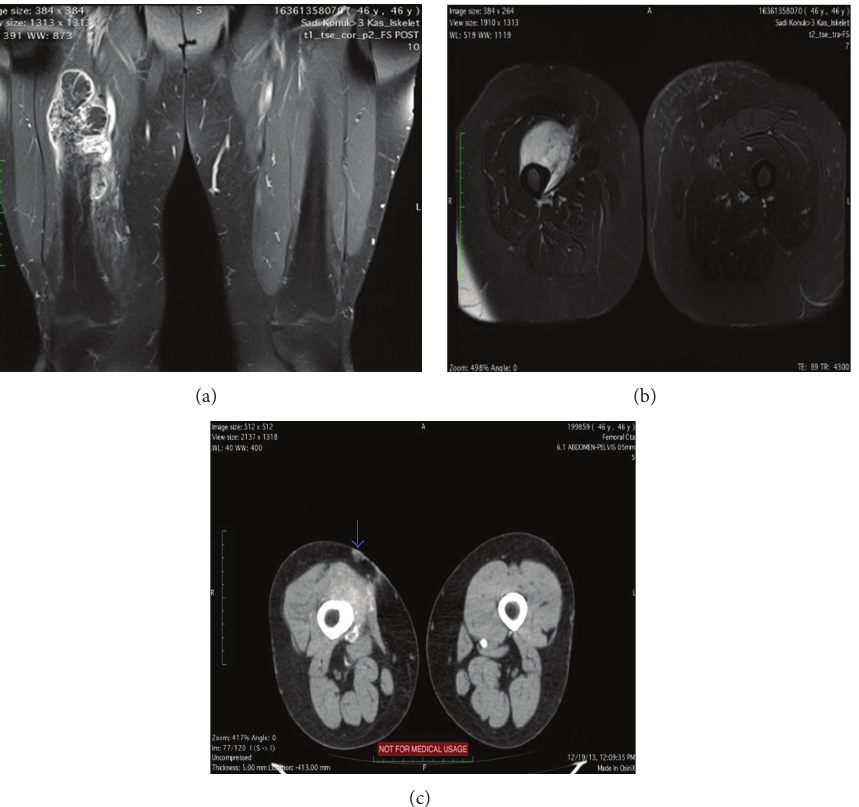
Figure 2: (a) MRI demonstrating tumoral lesion (coronal). (b) MRI demonstrating tumoral lesion (axial). (c) MRI demonstrating cutaneous